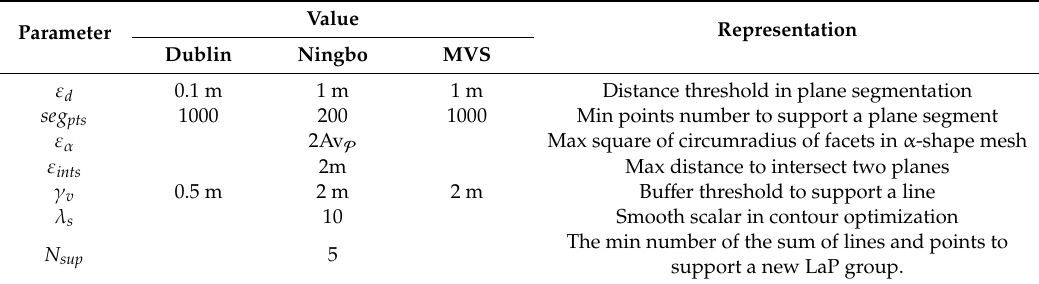
Table 3. Parameter settings and representation.